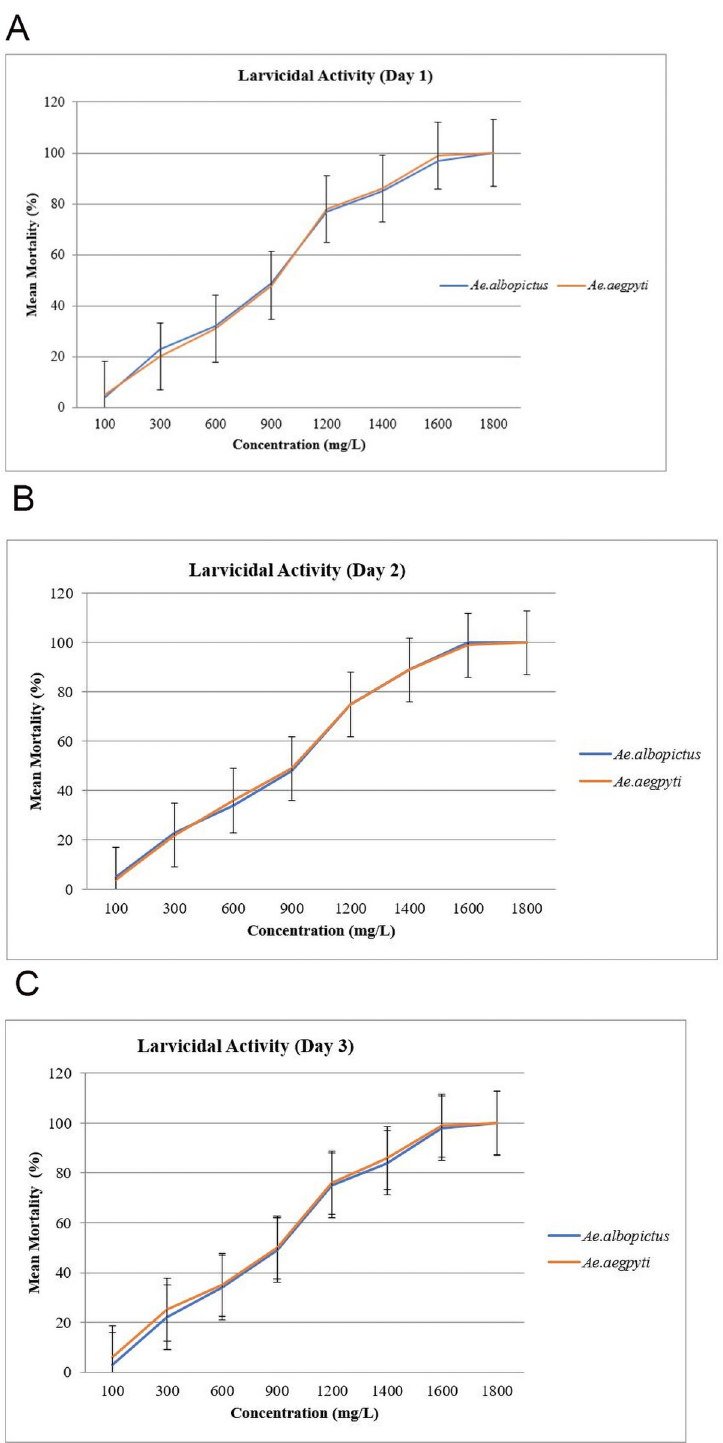
Fig 2. (A-C) Mortality rate from Day 1 till Day 3 of Aedes aegypti and Aedes albopictus larvae after exposure to Areca catechu nut